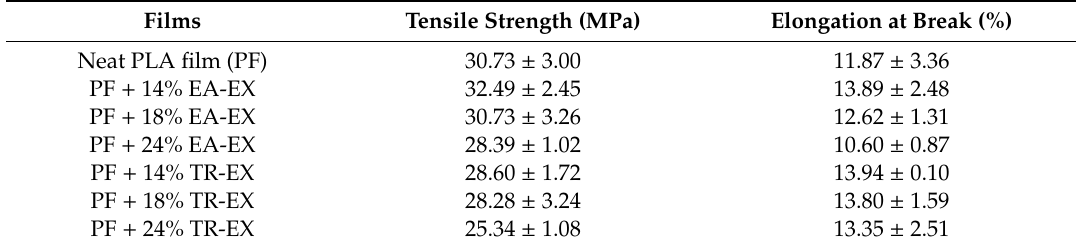
Table 3. Tensile strength and elongation at break of the PF and the UV-SF with di ff erent extracts